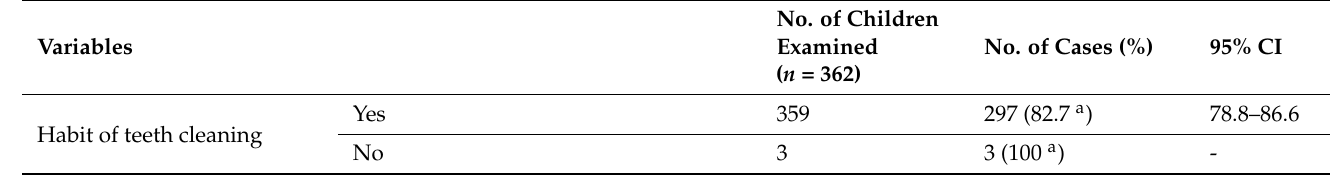
Table 2. Prevalence of dental caries in relation to dental